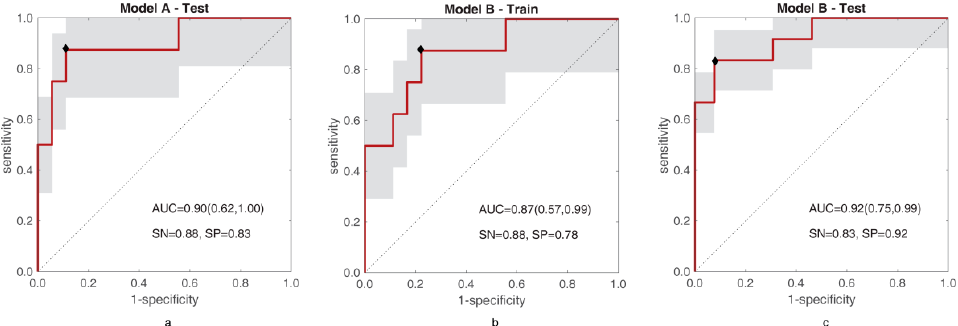
Figure 6. ROC curves for test of model A ( a ), and training ( b ) and test ( c ) of model B are shown. In each figure, the area under the ROC curve (AUC) is reported together with sensitivity (SN) and specificity (SP).